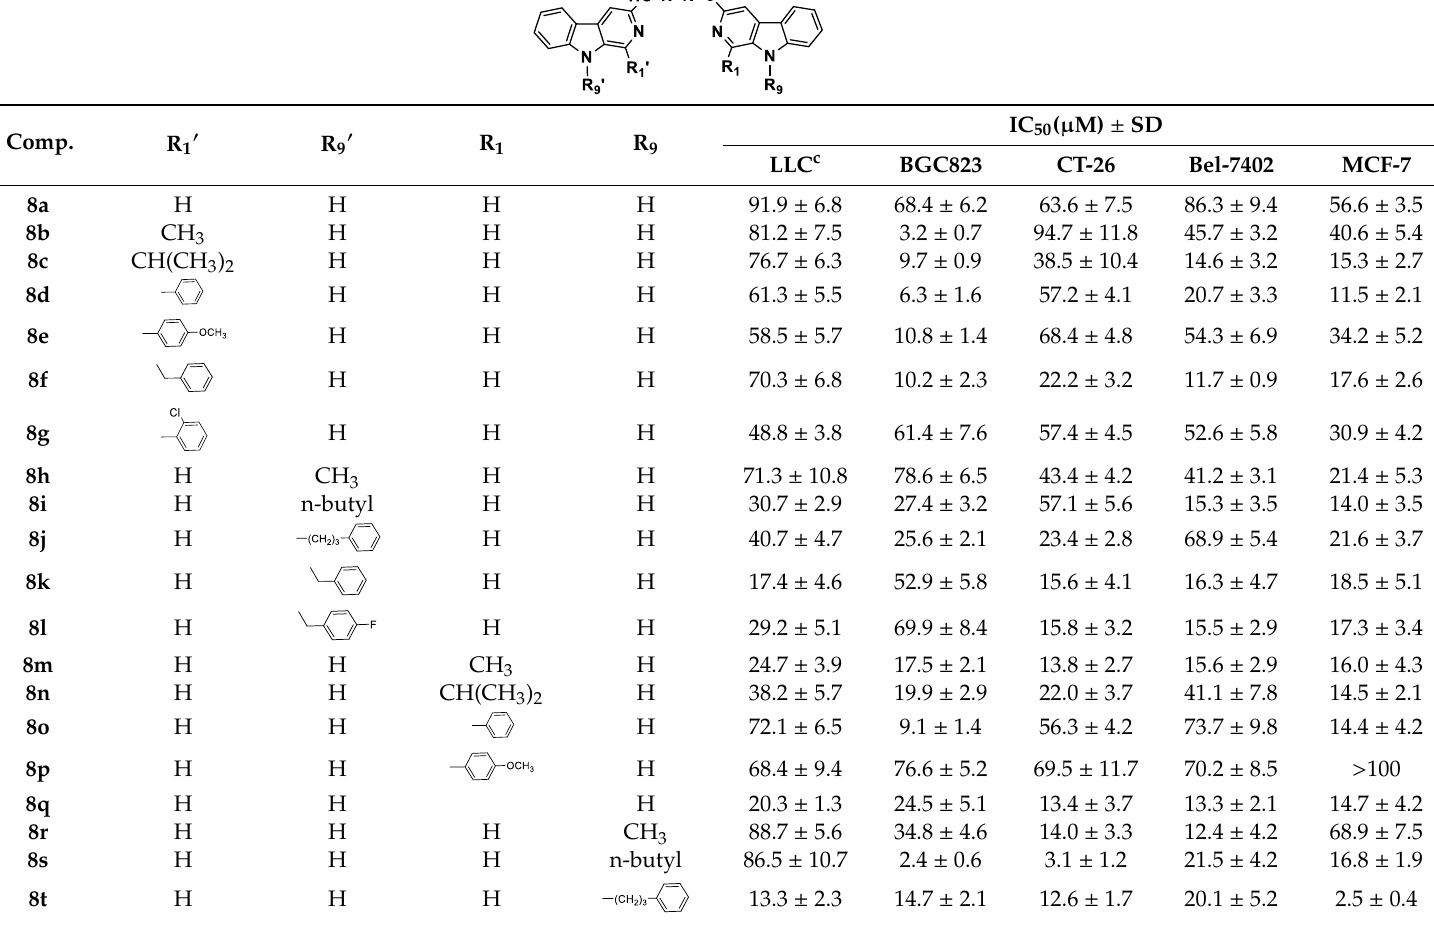
Table 1. Cytotoxic activity of acylhydrazone linked heterobivalent β-carbolines 8a – ab in vitro a (IC 50 , µM b ).